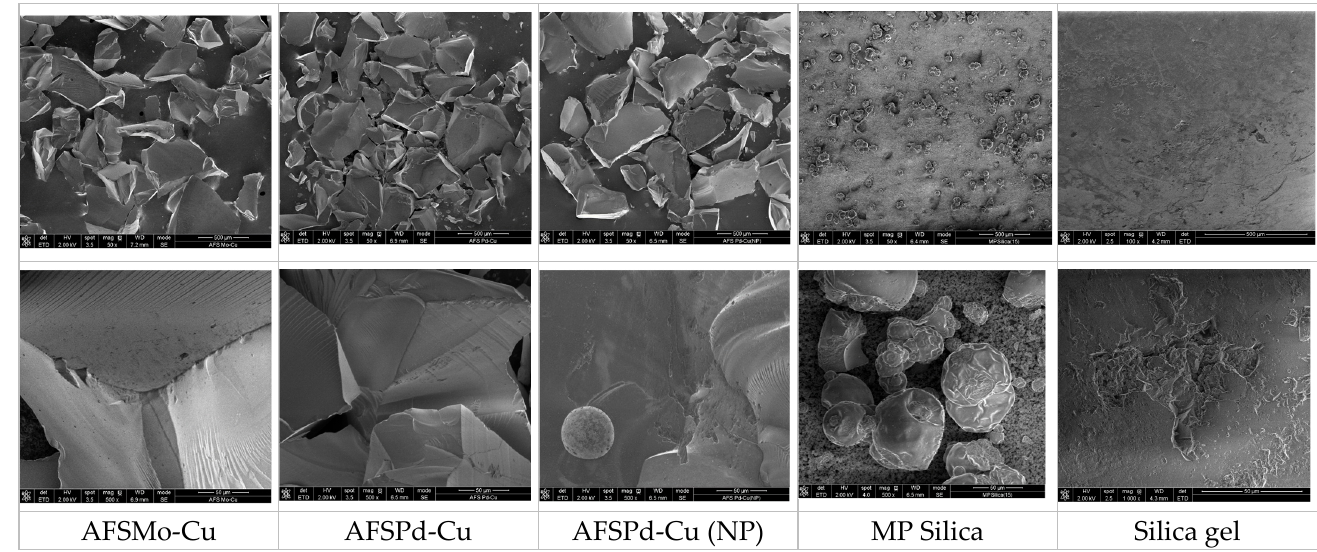
Figure 2. Morphology analysis of adsorbents analysed in this study. MOS samples denoted as AFS group had a very similar morphology. They consist of irregular particles of various shapes and sizes. The structure of the sorbent particles was smooth and sharp. The average size of these particles was approximately 500 µm. In some images, areas where “grooves” appear on the surface or a “stepped” structure are present. Fine round pores on the surface of the particles might be observed at some points. In the case of samples doped with metal nanoparticles—AFSPd-Cu (NP), also sphere-shaped metal particles were